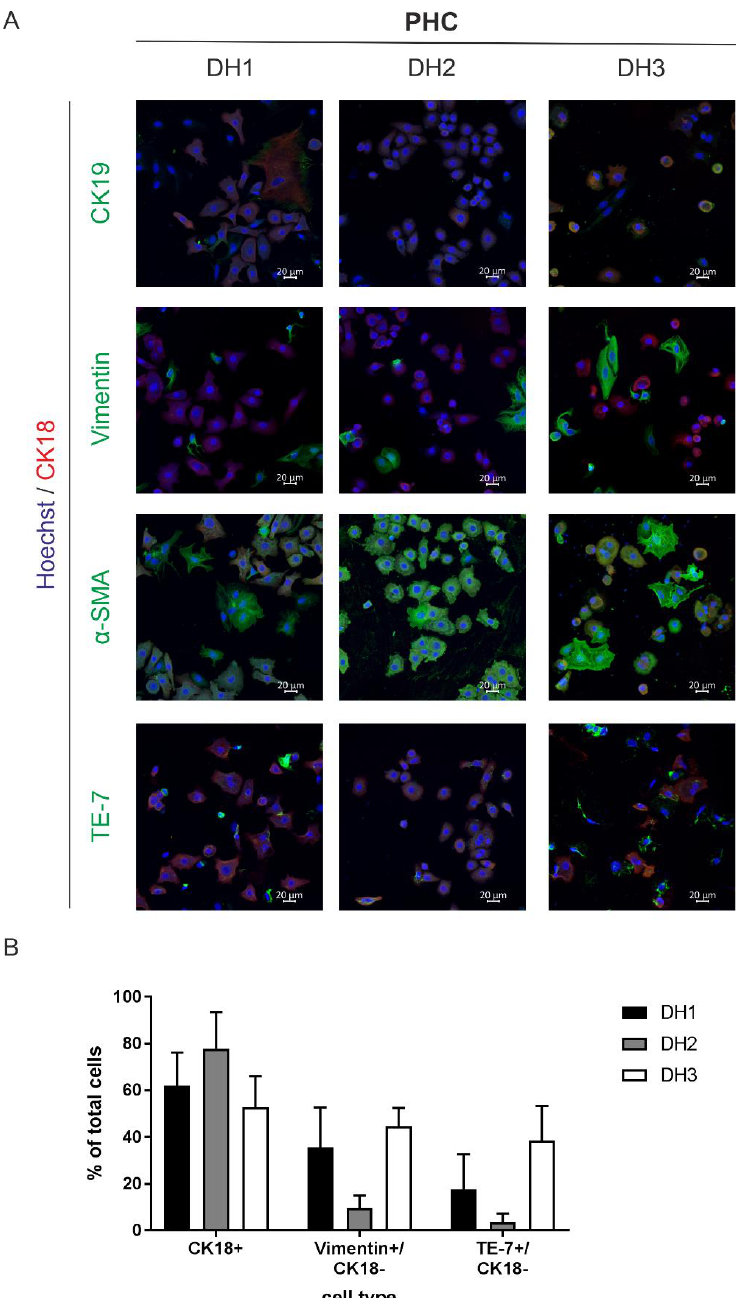
Figure 1. Characterization of the attached cell fractions isolated from HCC tissue samples. ( A ) All primary tumor cells were nuclei-stained with Hoechst (blue) and CK18 (red) as a marker for cells of hepatocellular origin. Additionally, cells were stained with a biliary/progenitor or tumor stem cell marker (CK19), an early differentiating epithelial cell marker (vimentin), a marker for liver fibrosis progression ( α -SMA) and a fibroblast marker (TE-7, all marked with green). Cells were analyzed after overnight adherence by immunofluorescence staining and laser scanning microscopy at 20× magnification. The scale bar is 20 µm. ( B ) Immunofluorescence staining of cells of donor DH1-DH3 were used for marker quantification. Five randomly taken images per well were acquired at 20× magnification using laser scanning microscopy, and the cells were counted manually based on their specific staining. Total cells were counted by Hoechst nuclei staining. Data are shown as means + SD (N = 1, n = 5). Abbreviations: PHC, primary human hepatoma cell; CK, cytokeratin; α -SMA, alpha-smooth muscle actin; TE-7, antifibroblast antibody